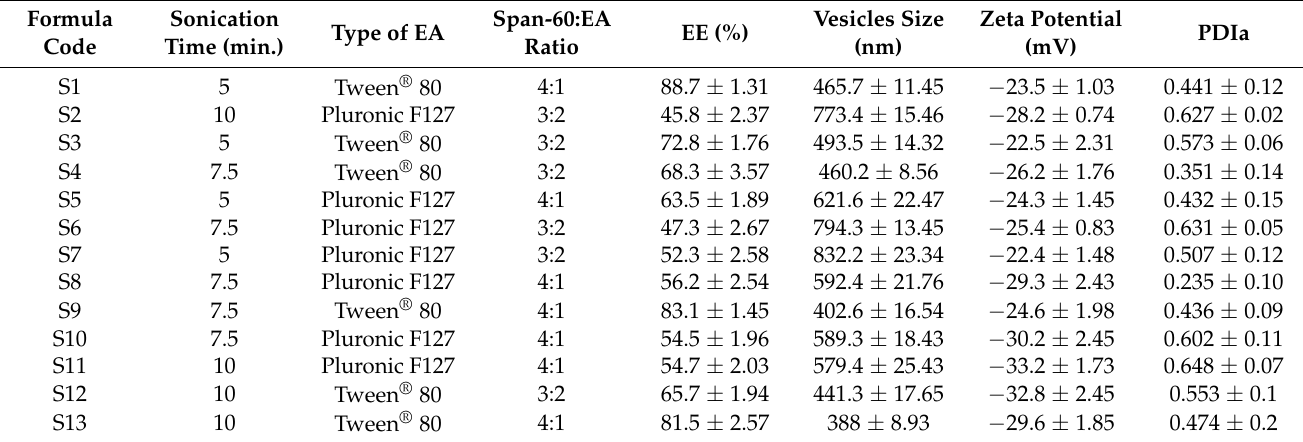
Table 2. I-optimal Design of BGT-loaded NSPs with their